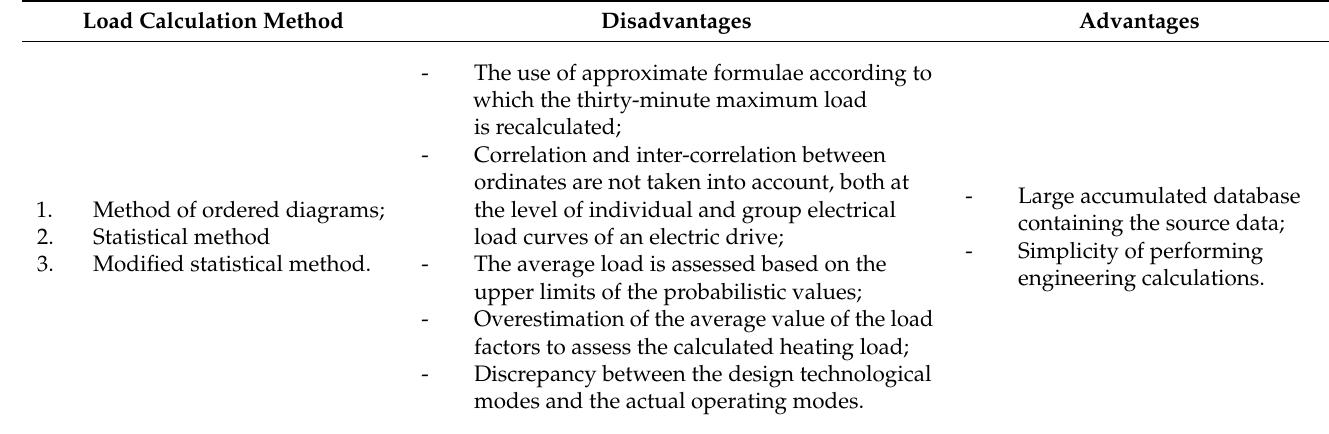
Table 4. Advantages and disadvantages of existing load calculation methods used for calculating electrical